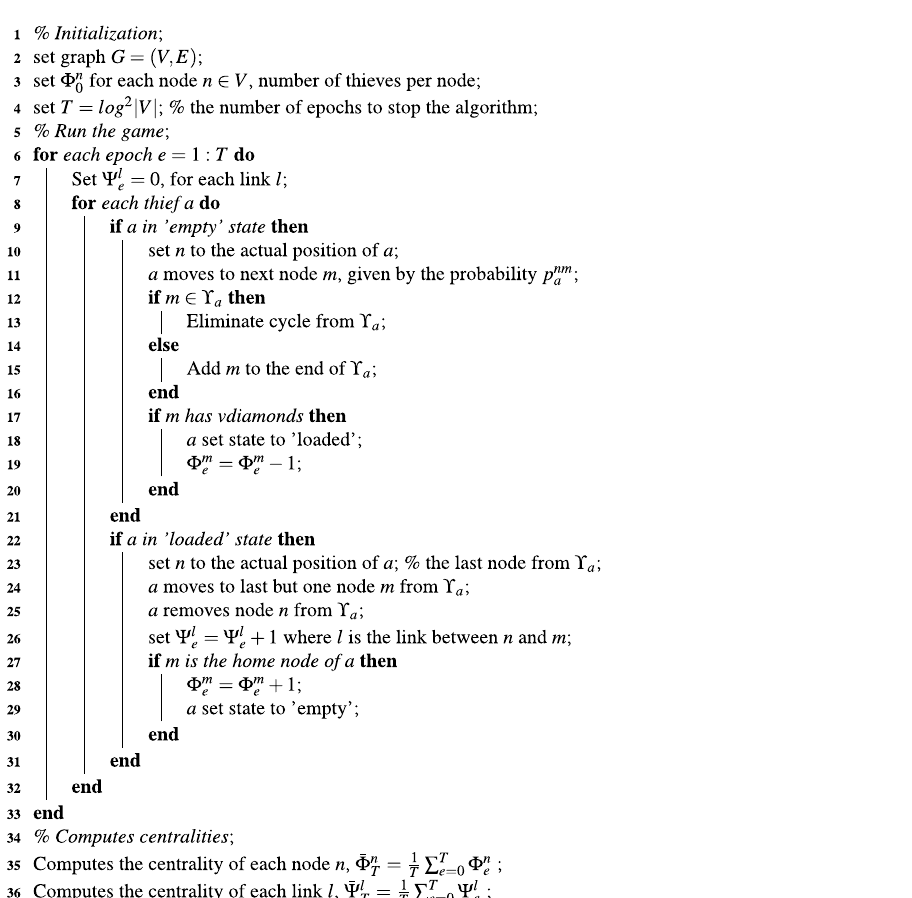
Algorithm 1. Game of Thieves (GOT)